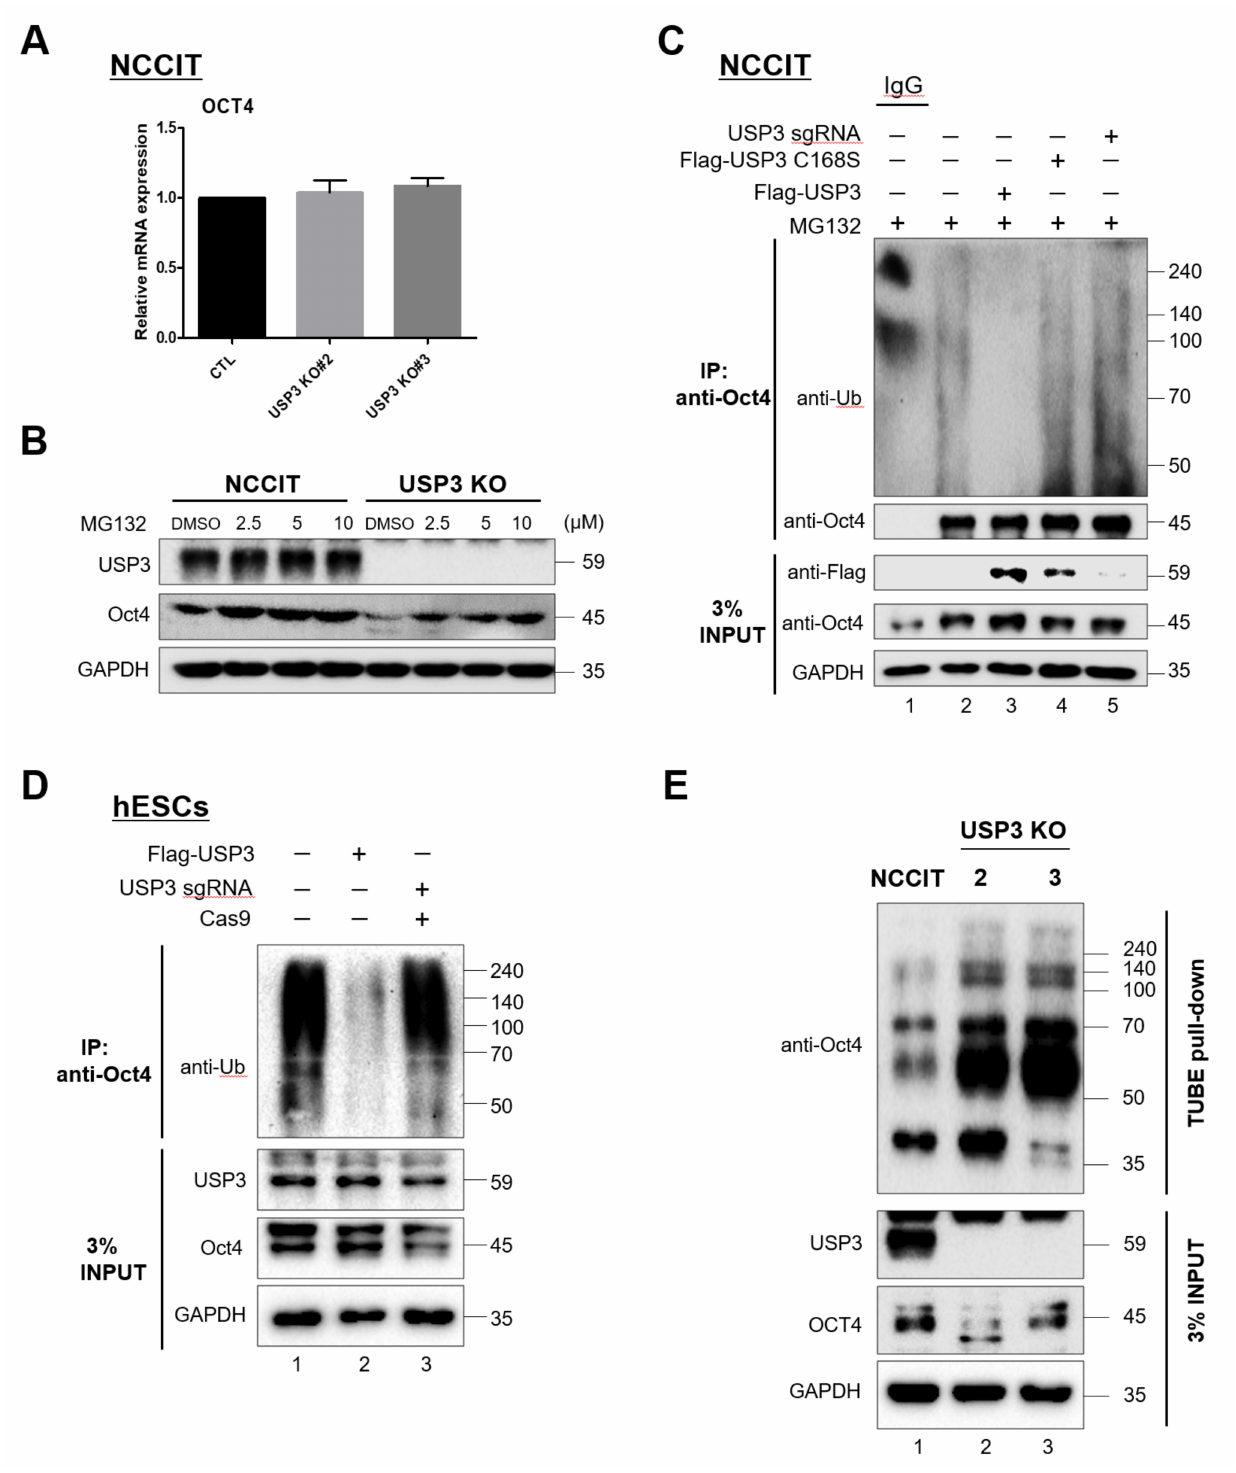
Figure 4. Deubiquitination of Oct4 by USP3. ( A ) The effect of USP3 gene knockout on the mRNA expression of Oct4 was analyzed by qRT-PCR analysis with specific primers. Representation of relative mRNA expression levels of Oct4 after normalization with GAPDH . ( B ) USP3-expressing and USP3-depleted NCCIT cells were treated with the proteasome inhibitor MG132 (DMSO as control, 2.5, 5, or 10 µ M MG132) for 6 h at the indicated concentrations and analyzed by immunoblotting against the indicated antibodies. GAPDH was used as a loading control. ( C ) For endogenous Oct4 deubiquitination assay in NCCIT, Flag-USP3, Flag-USP3CS, and sgRNA targeting USP3 were transfected into NCCIT